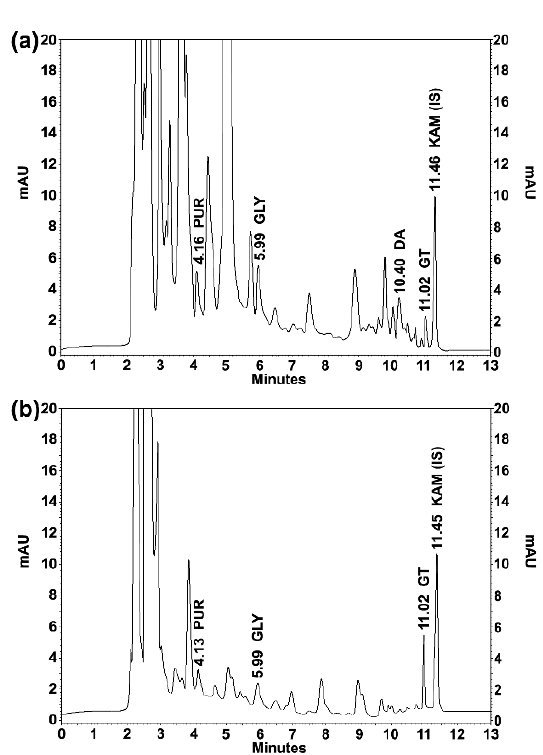
Figure 5. Chromatograms of: (a) extracted blank urine sample, (b) extracted urine samples enriched with analyte concentrations at the middle concentrations level obtained using the HPLC-DAD method.